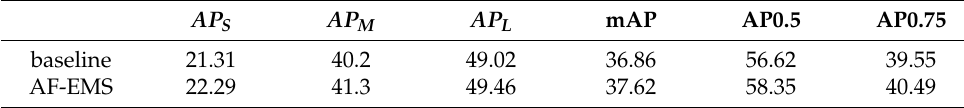
Table 8. Quantitative comparison of the baseline and our method on the HBB task in test set of DOTA dataset. Method YOLOv2 SSD